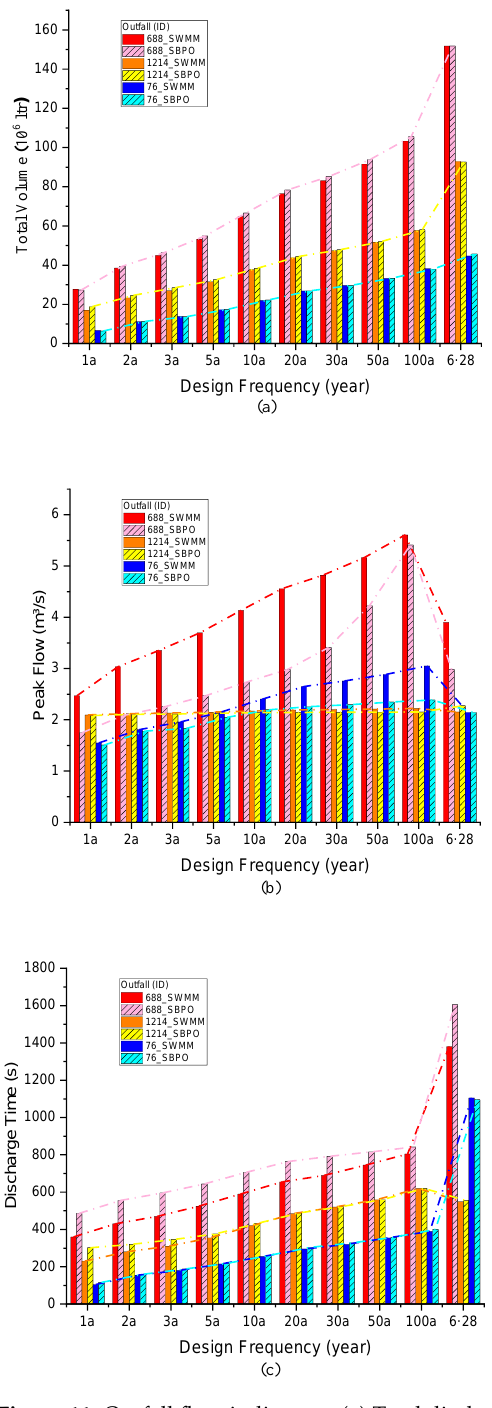
Figure 11. Outfall flow indicators. ( a ) Total discharge volume; ( b ) peak flow; ( c ) discharge Time. It can be found from Figure 11a that in the 10 rainstorms with design occurrence frequency ranging from 1a to 100a, the maximum error of the total effluent volume at the outfall is only 2.261 × 10 6 LTR, and the relative error is 2.18%, which indicates that the two